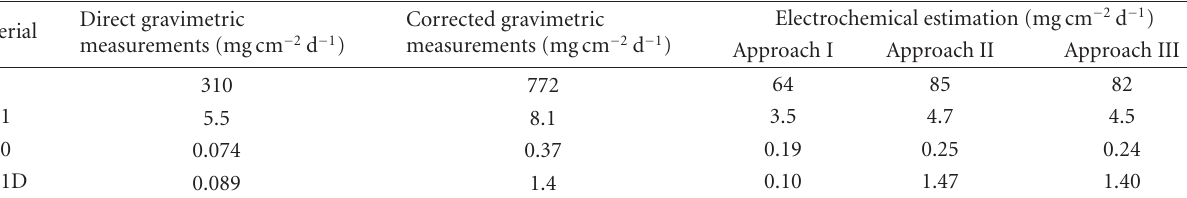
Table 4: Average corrosion rate for samples immersed in 3.5 wt.% NaCl solution. Test duration was 6 hours for Mg metal and 10 days for AZ31, AZ80 and AZ91D alloys.